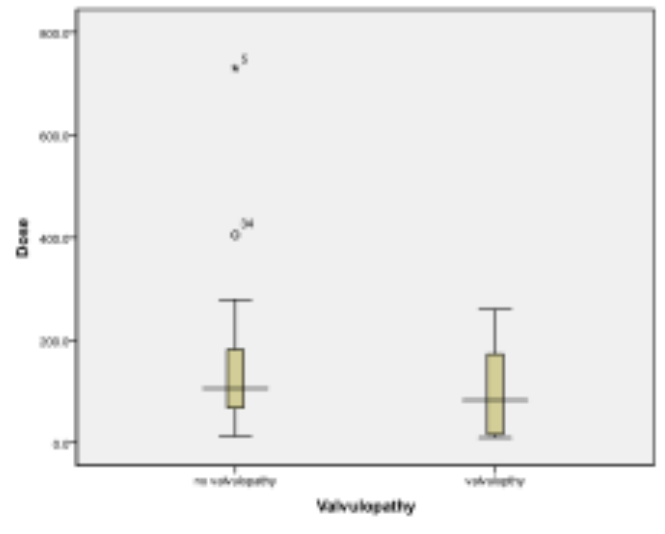
Figure 1. Stem and leaf